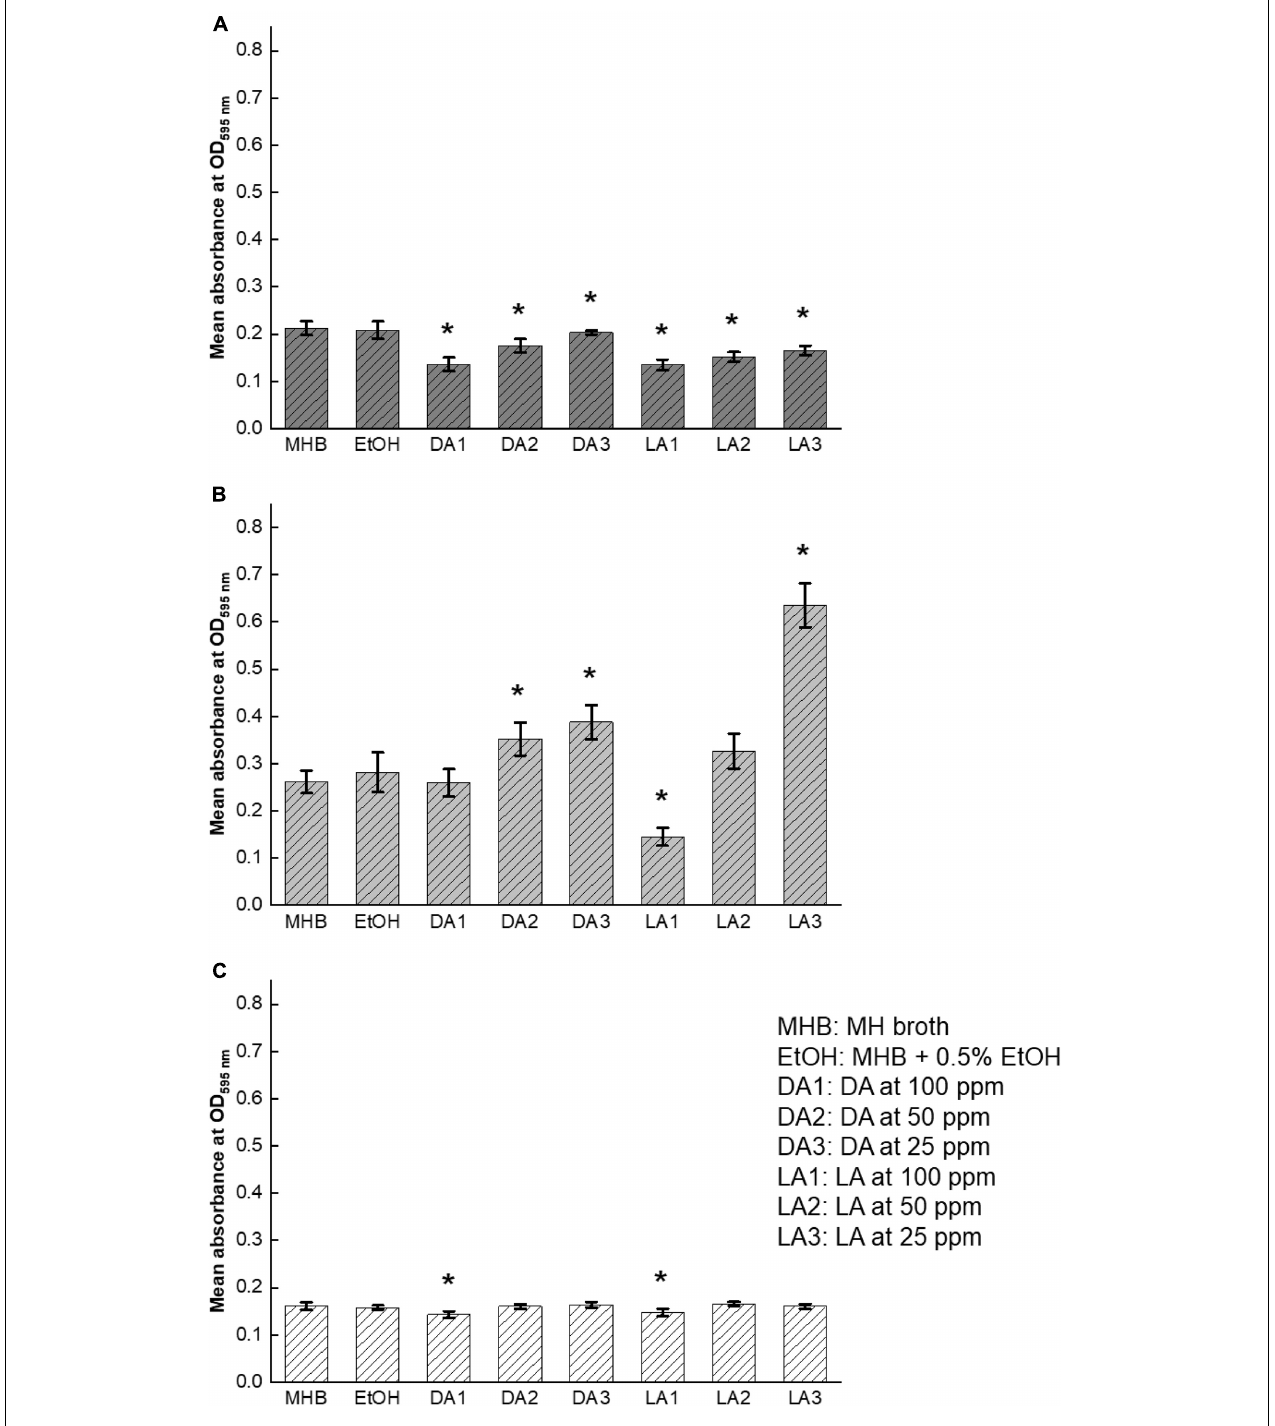
FIGURE 4 | Effect of decanoic acid (DA) and lauric acid (L.A.) on biofilm formation of C. jejuni . C. jejuni strain F38011 (A) , NCTC11168 (B) , and ATCC33560 (C) . Total biomass of the formed biofilms was quantified by crystal violet staining at OD 595nm after 72 h incubation with or without fatty acids at 37 ◦ C under microaerobic condition. MH broth containing 0.5% ethanol was used as ethanol control. MH broth and MH broth containing 0.5% EtOH are served as the broth control and negative control, respectively. Three biological replicates were performed. * Statistical significance between negative control and treated samples was determined by one-way ANOVA coupled with Dunnett’s multiple comparisons test ( P < 0.05 was considered as statistically significant).